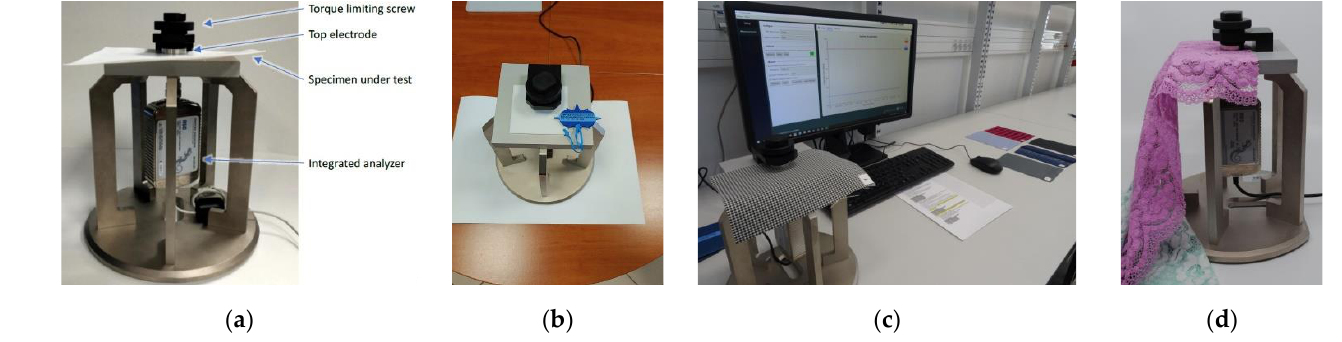
Figure 6. Measurement of dielectric permittivity: ( a ) epsilometer; ( b ) calibration of the measurement apparatus; ( c ) testbed; ( d ) sample testing.